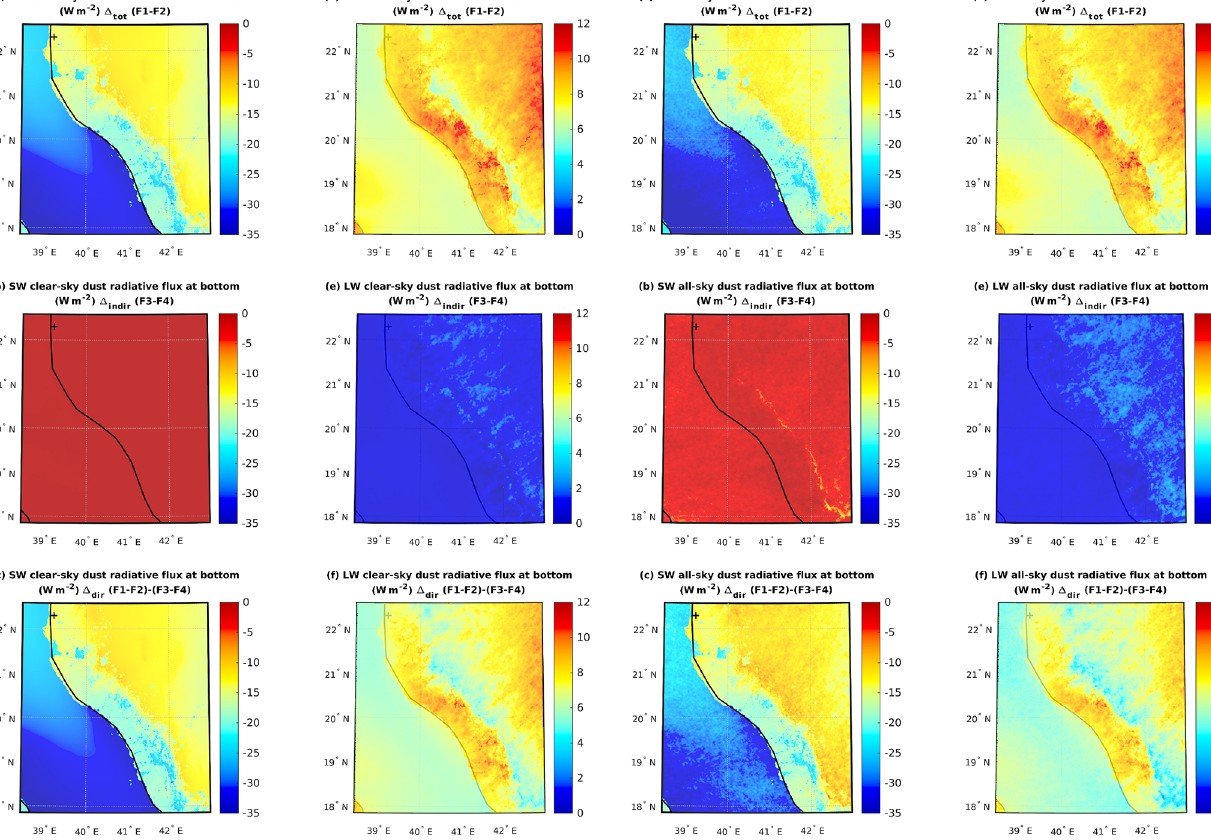
Figure 12. Effects of dust on the clear-sky (left two columns) and all-sky (right two columns) radiative fluxes at the bottom of the atmosphere calculated from 10-year August average WRF-Chem